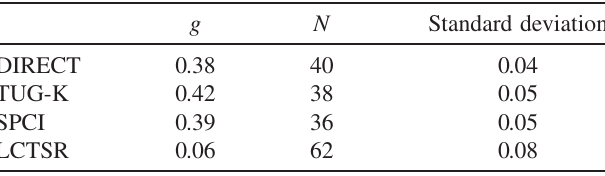
TABLE II. Average normalized gains on three conceptual in- ventories and the LCTSR. Students taking the conceptual phys- ics course were assessed via DIRECT and TUG-K. Students taking conceptual astronomy were assessed via the SPCI. Matched data from the LCTSR were obtained from both